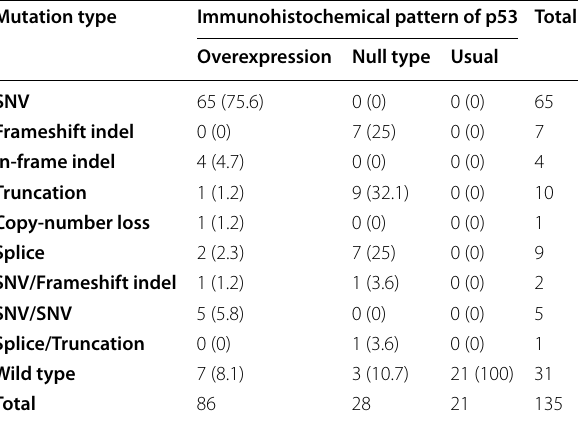
Table 2 Immunohistochemical staining patterns and